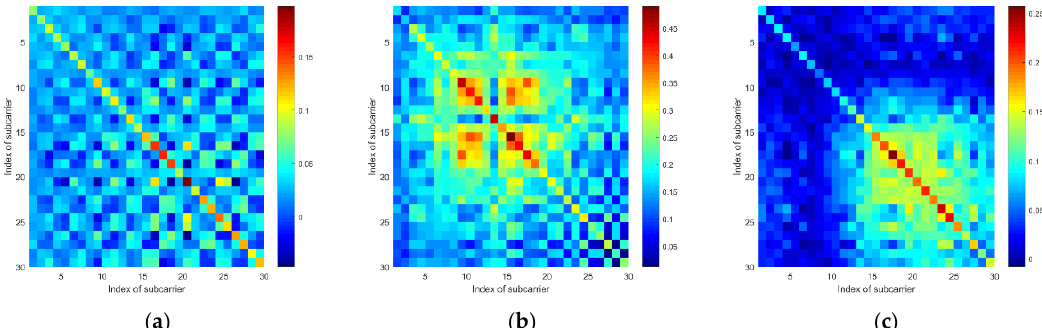
Figure 9. The CSI amplitude’s covariance matrices of 3 different communication links: ( a ) Link 1, ( b ) Link 2, and ( c ) Link 3.